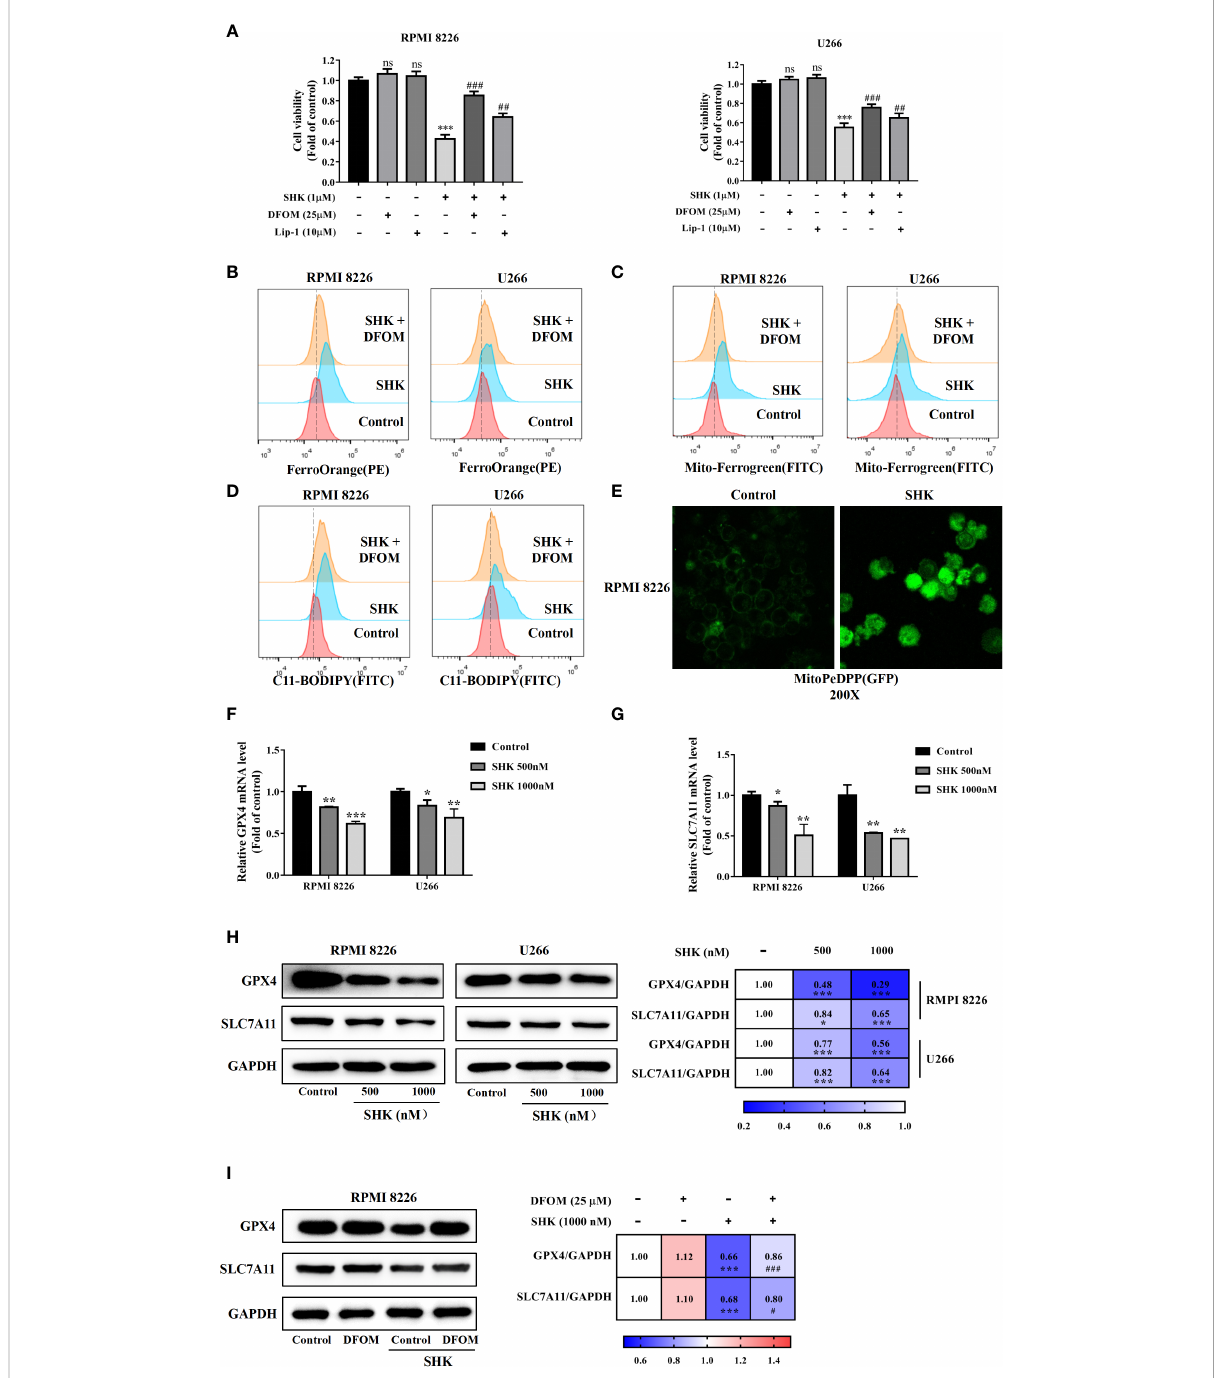
FIGURE 2 SHK facilitated MM cell ferroptosis in vitro . (A) The effects of SHK on the viability of MM cells in the presence or absence of DFOM and Lip-1. (B) FerroOrange probe was used to detect the level of Fe 2+ in MM cells. (C) Mito-FerroGreen probe was to detect the level of mitochondrial Fe 2 + in MM cells. (D) BODIPY 581/591 C11 probe was used to detect the level of lipid ROS in MM cells. (E) MitoPeDPP probe was used to detect the level of mitochondrial lipid ROS in MM cells. The effect of SHK on the transcription of GPX4 (F) and SLC7A11 (G) . (H) The effect of SHK on the translation of GPX4 and SLC7A11. (I) The effects of SHK on the protein level of GPX4 and SLC7A11 were determined in the presence or absence of DFOM. All the values are presented as the mean ± SD. ns, not signi fi cant; * p < 0.05, ** p < 0.01,*** p < 0.001, compared to control; # p < 0.05, ## p < 0.01, ### p < 0.001, compared to